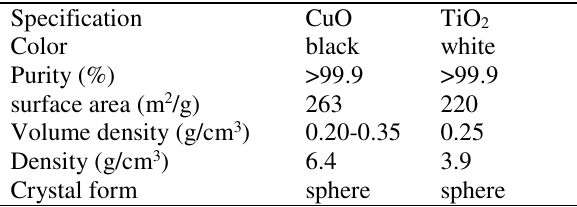
The main properties of CuO and TiO 2